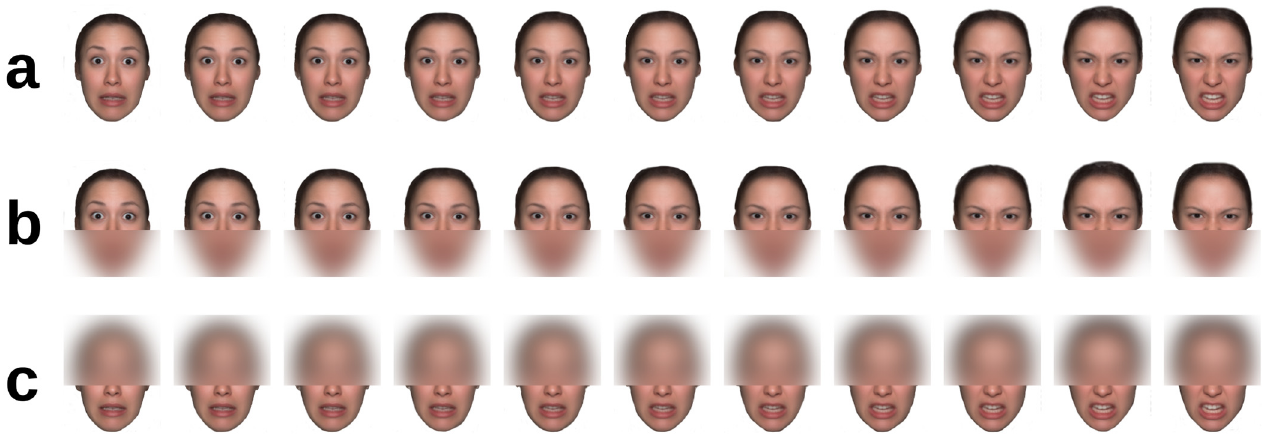
Fig 1. Design of Experiment 1. Illustration of a face morphed from the original fearful (outer left) to the original angry expression (outer right) in 9 intermediary steps, resulting in a total of 11 face morphs; a, whole face; b, upper half intact ('eyes' condition); c, lower half intact ('mouth' condition); due to copyright restrictions, the depicted example is an in-house generated averaged face based on 16 different identities and not depicting an actual person. This example is a representative illustration of the type of stimuli used but was not itself part of the present experiment.